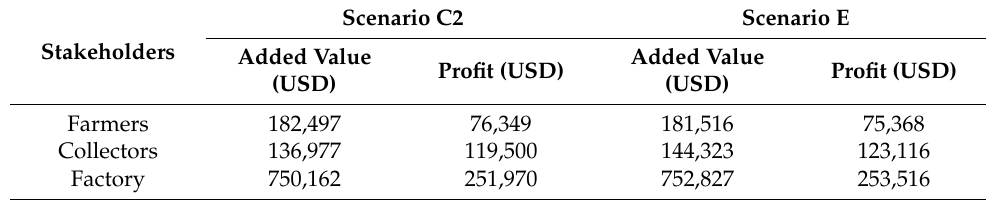
Figure 10. Sensitivity analysis of parameters on ( a ) farmers’ profits, ( b ) collectors’ profits, and ( c ) factory profits in scenario E. Table 5. Added value and profit obtained for each stakeholder in new sustainable value chain.